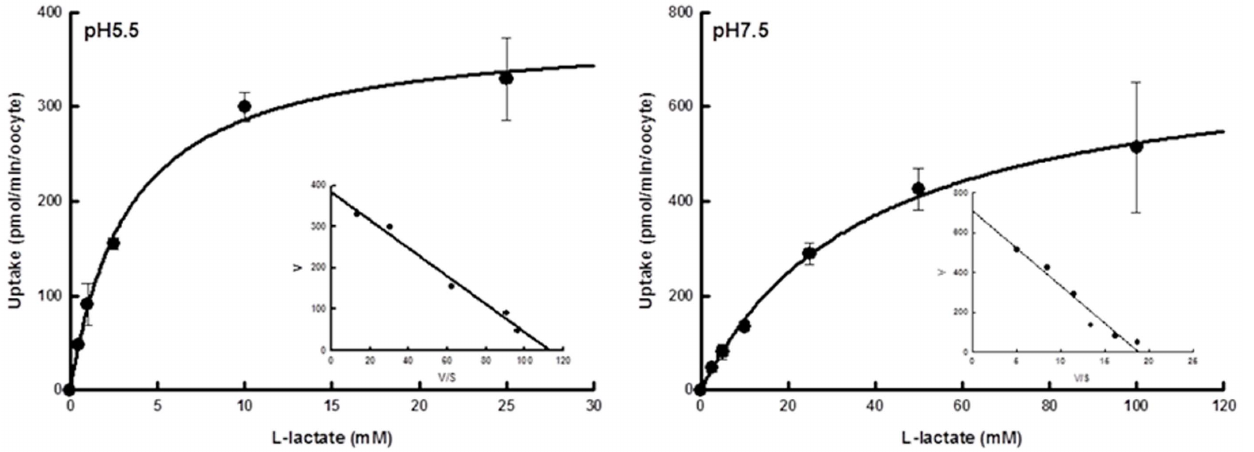
Figure 2. Saturation kinetics of hMCT4-mediated L-lactate transport. Uptake of L-lactate was measured with 10 min incubation at 25 u C in transport buffer of pH 5.5 or pH 7.5 in the presence of an increasing concentration of L-lactate. hMCT4-specific uptake was calculated by subtracting the uptake in water-injected oocytes from the uptake in hMCT4 cRNA-injected oocytes. Only the hMCT4-specific uptake was used for kinetic analysis. The inset shows an Eadie-Hofstee plot of L-lactate transport activity. Each point represents the mean 6 S.E. of three – five experiments.